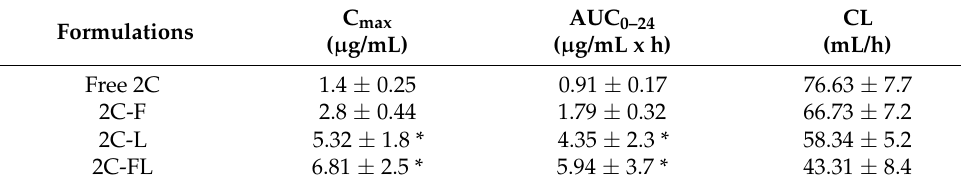
Table 2. Pharmacokinetic parameters of 2C in the blood of healthy mice after the intraperitoneal administration of 2C-F, 2C-L, and 2C-FL nanoparticles. Data are presented as the mean ± SD of three independent experiments. Free 2C versus 2C-L or 2C-FL; * p < 0.05. C max : highest concentration of a drug; AUC 0–24 : area under the plasma concentration–time curve from 0 to 24 h; CL: plasma clearance. Formulations